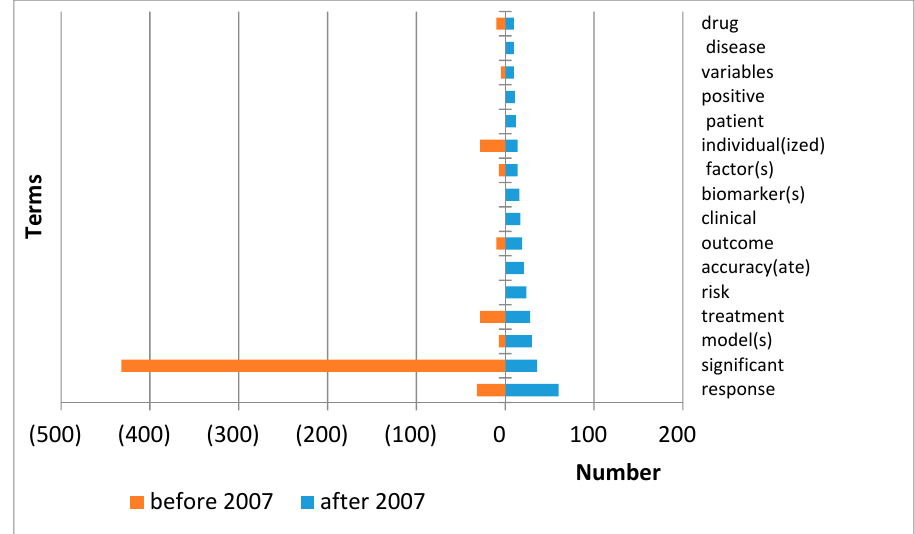
Figure 6. The frequency of occurrence of terms in the vicinity of the derivative “predictive” over the past decade.